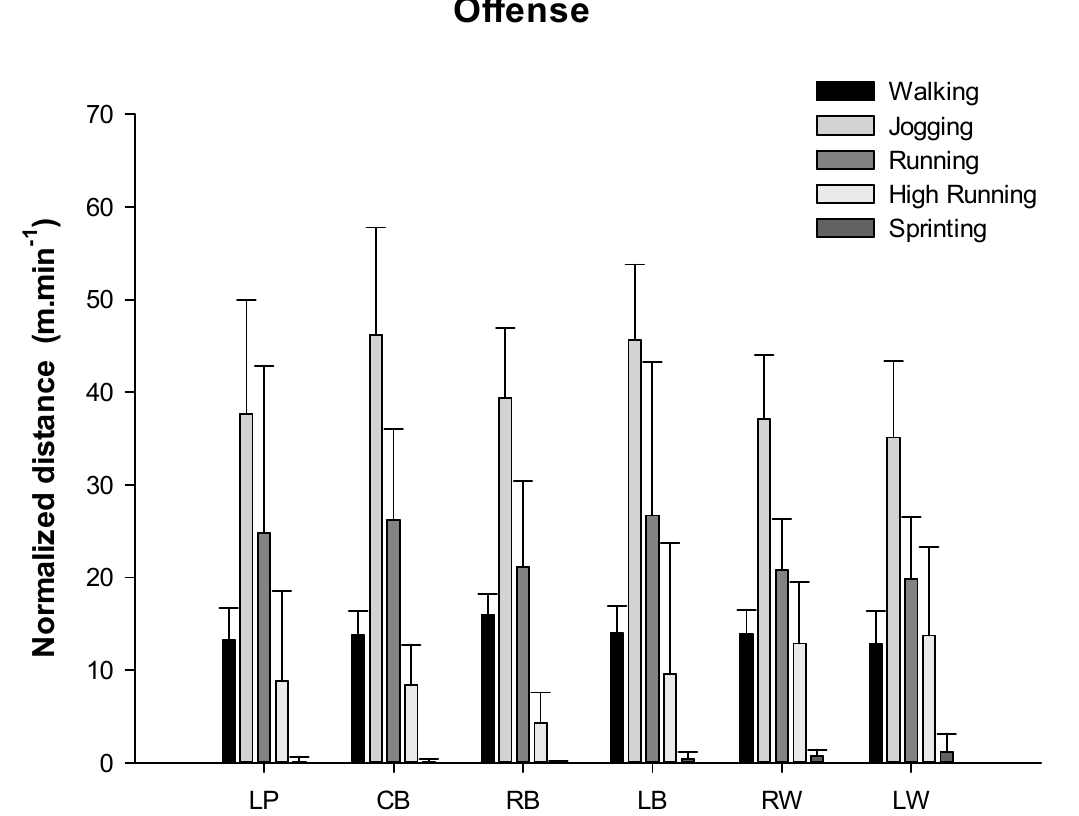
Figure 5. Distance covered in each locomotion category normalized according to the time spent in court in different playing positions during offense. Legend: left wing = LW, left back = LB, center back = CB; line player = LP; right back = RB; right wing = RW.